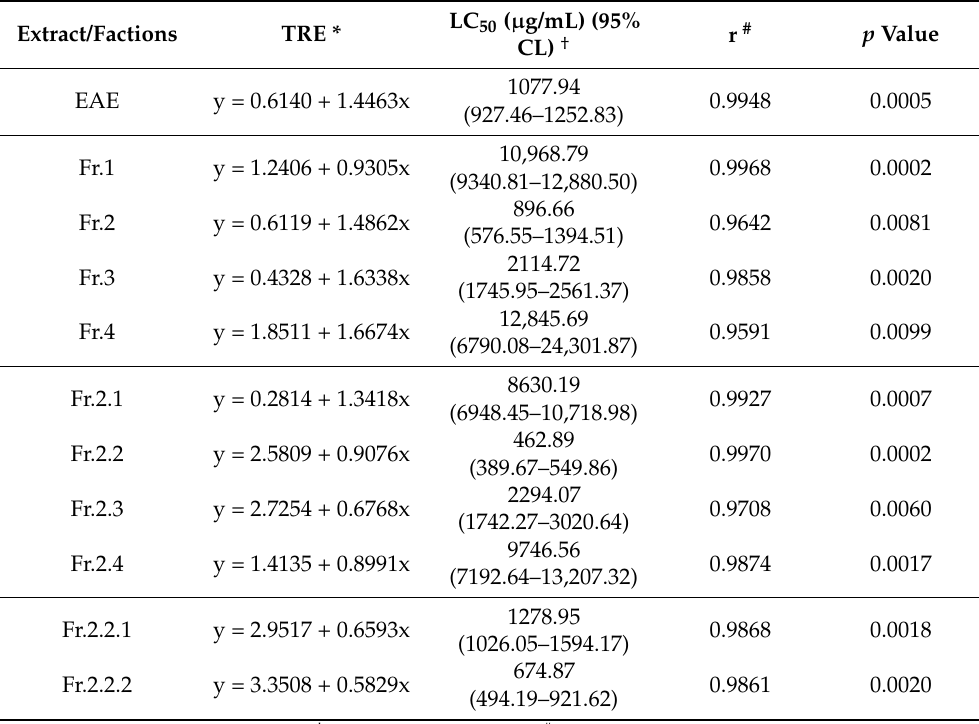
Table 3. Toxicity regression equation of ethyl acetate extract and fractions on day 6. Extract/Factions